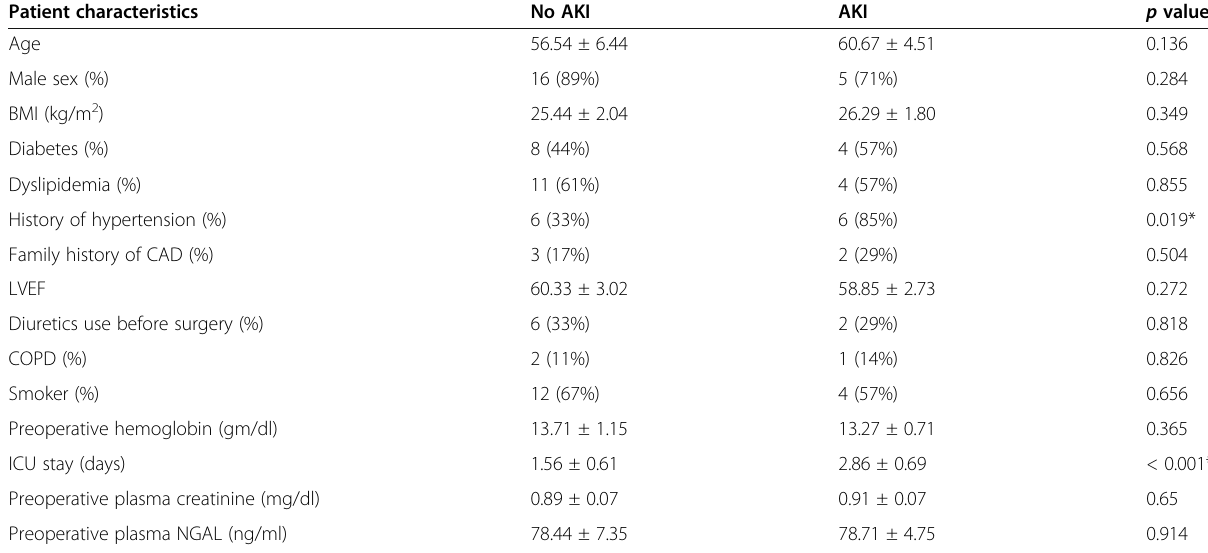
Table 1 Basic demographics and clinical data of both groups Patient characteristics